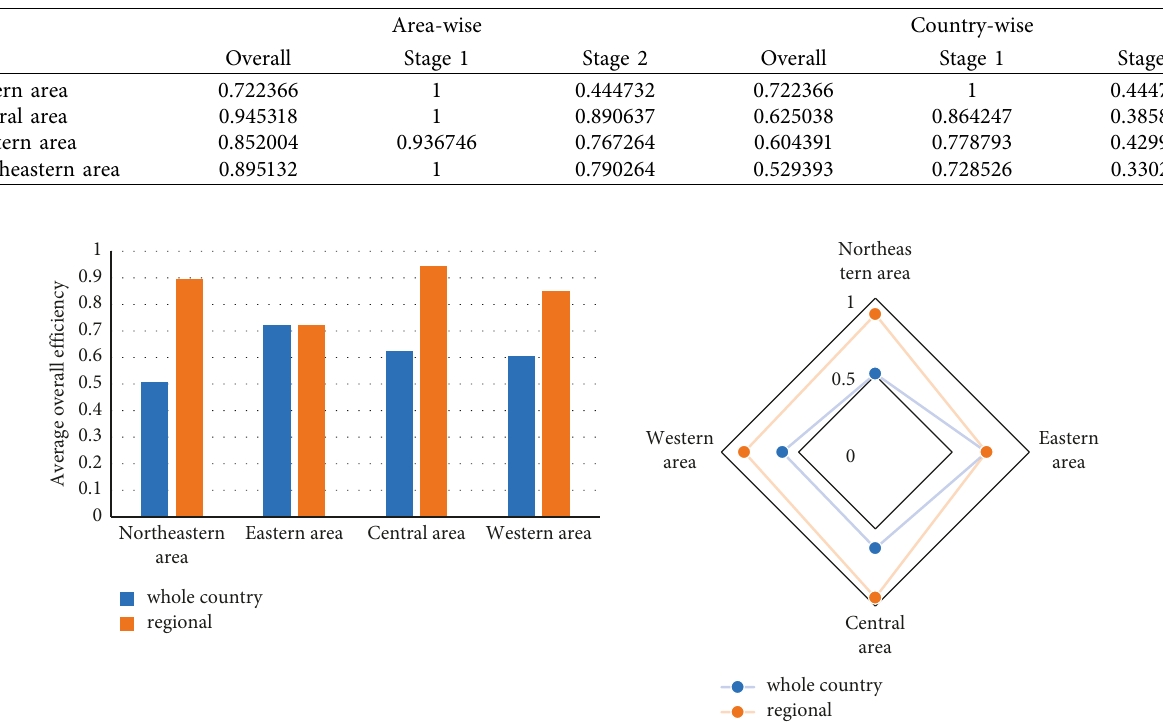
Table 10: Country-wise and area-wise average efficiency scores.